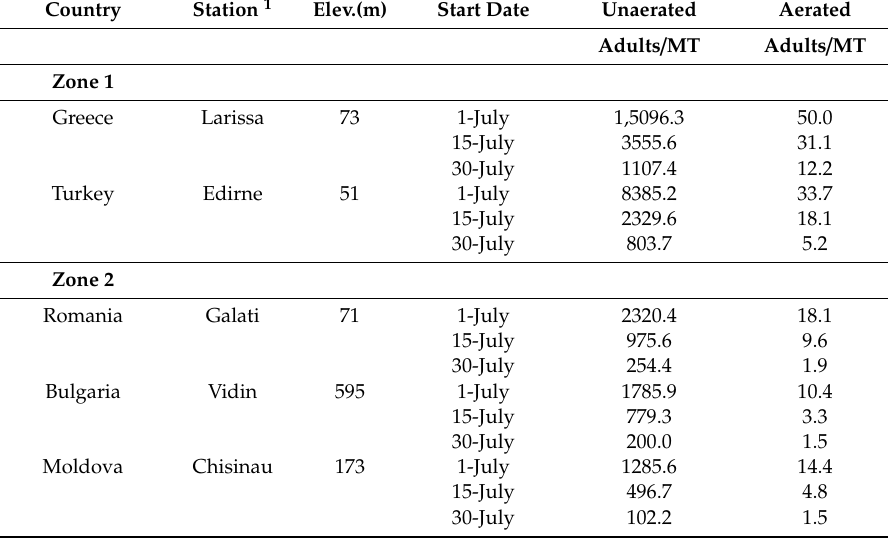
Table 2. Predicted number of adult S. oryzae per MT, in unaerated and aerated wheat at each station, based on the three di ff erent start dates and the starting value of 1.5 adult / MT. Stations grouped according to the order in Table